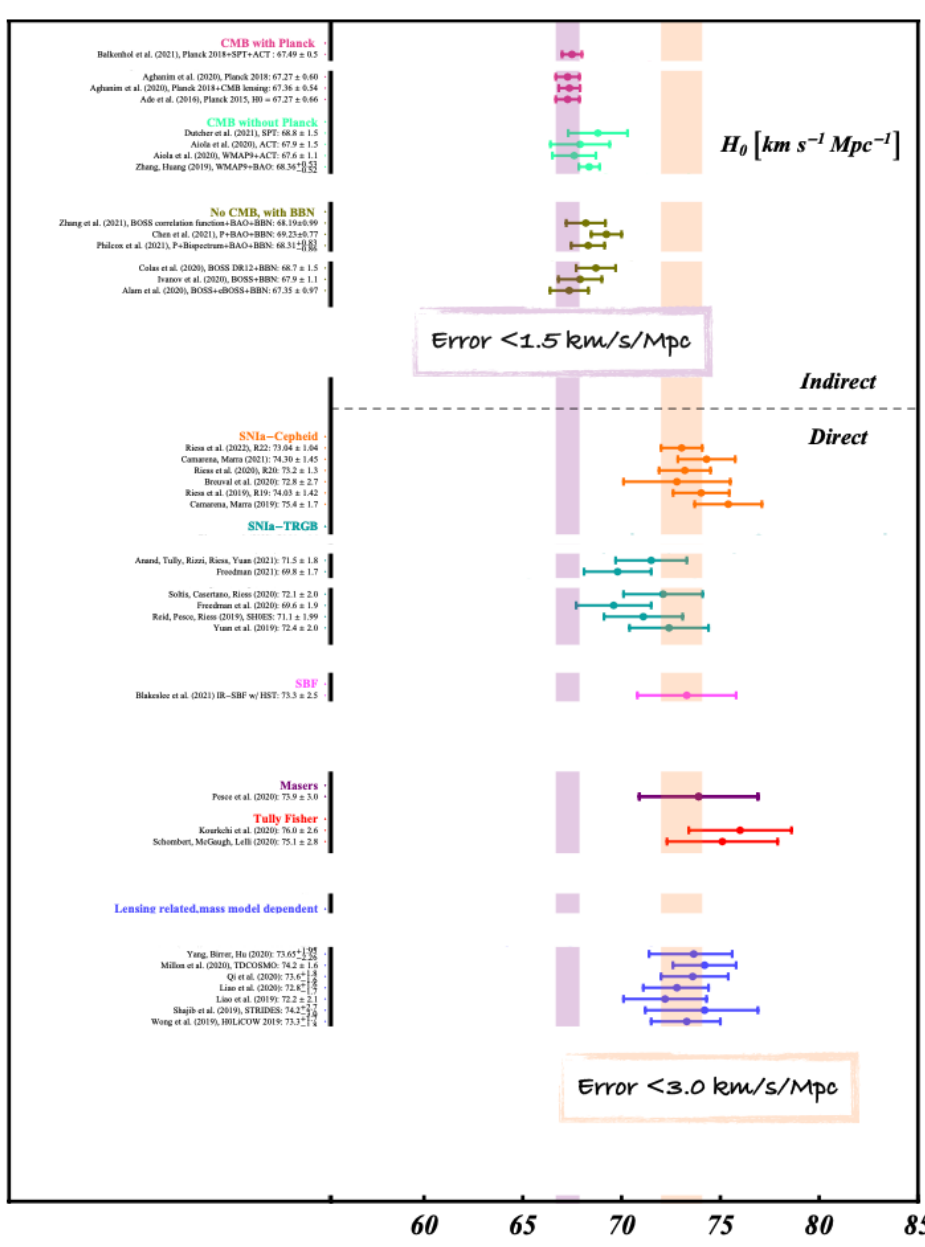
Figure 1. Filtered version of Figure 2 of Ref. [18] with only the high-precision measurements of H 0 . For the original figure, details, and references, see Ref.